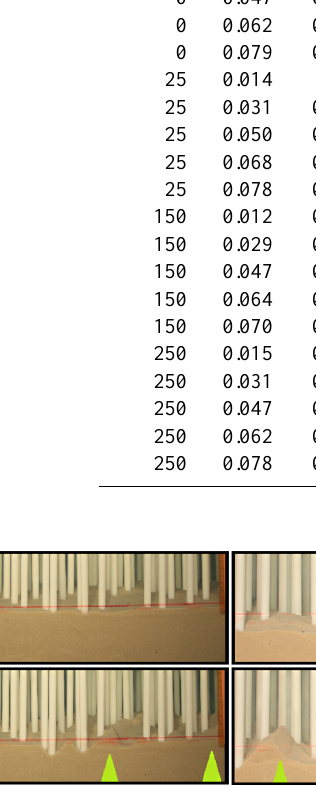
Figure 3. Side view: n = 150m − 2 , upstream (left) and downstream (right) edge of the array, before (up) and after (down) 5min running at f p = 30Hz. Notice the scour and bedforms forming within the array at the up- and downstream sections (as pointed by the green arrows). Red line is the initial reference for the bed level. Notice the factor of 2 increase in the vertical scale.